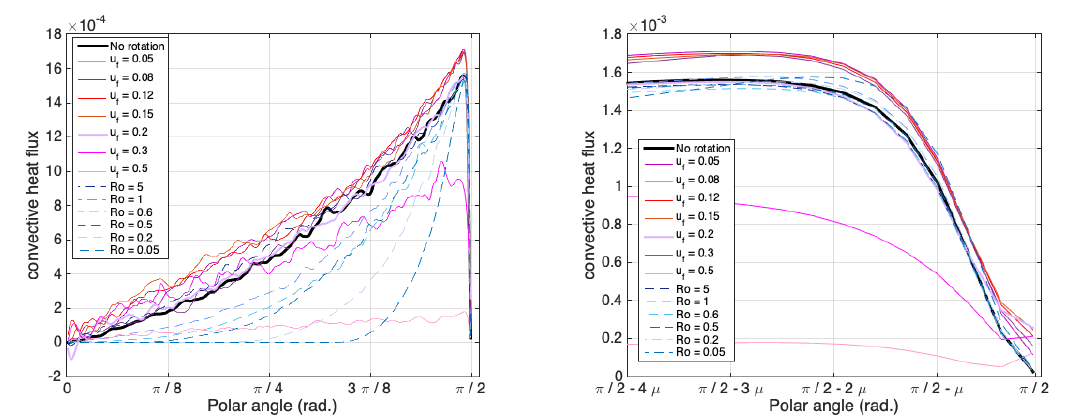
Figure 5. Left: Convective heat flux Φ ( l ) for various values of the Rossby number and of velocity boundary condition U f . Right: Zoom close to the equator with µ =